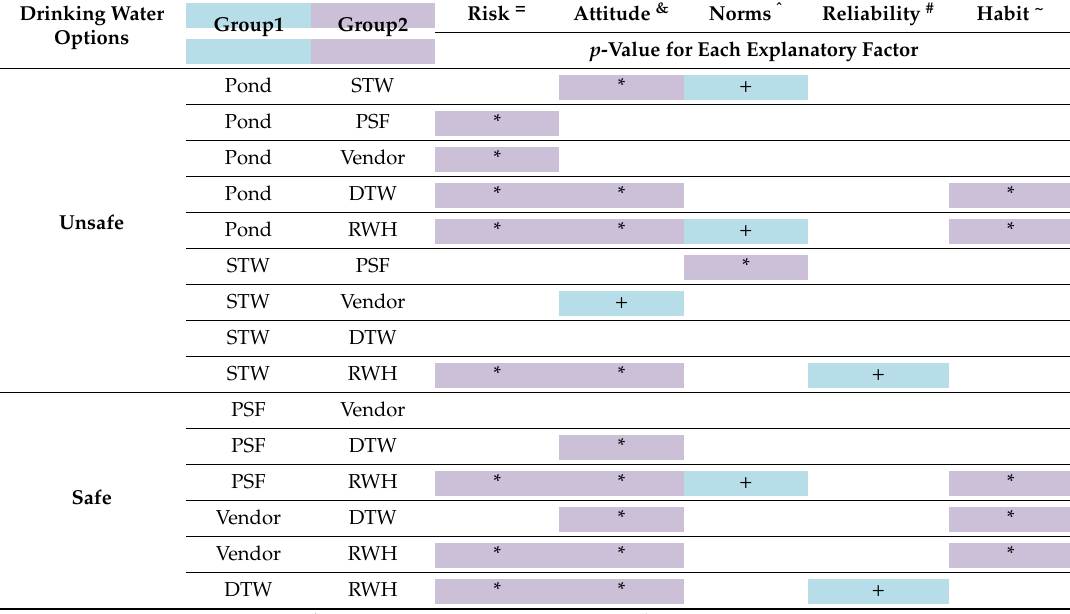
Table 5. Significant di ff erences in explantory factors between the drinking water options. Empty cells indicate non-significant pairs. The colours and symbols indicate, for the significant pairs, which group is higher: the first (teal + ) or the second (purple